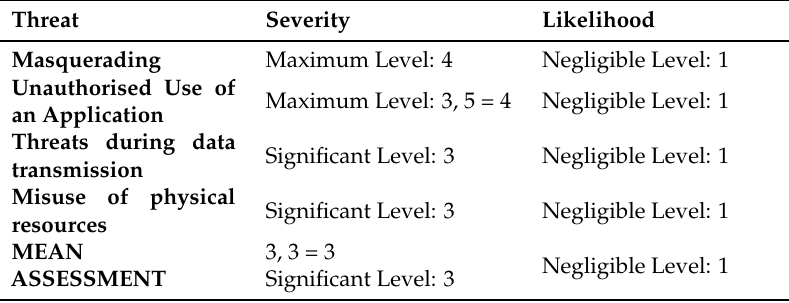
Table 2. Risk category: Illegitimate access to data.